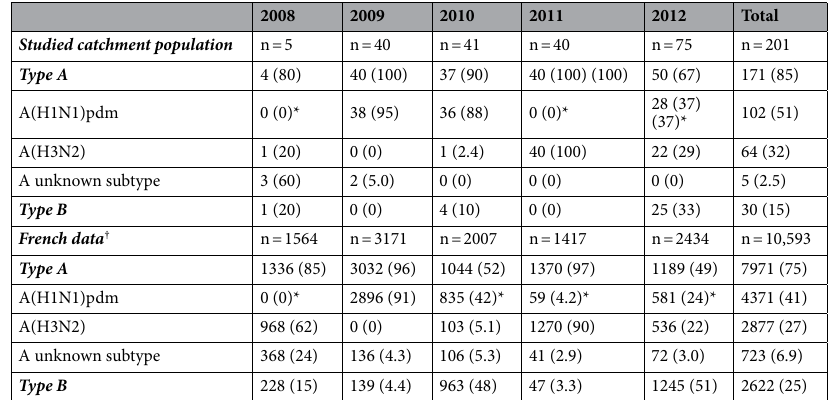
Table 2. Virological data. Data are number (%). * p < 0.05 versus 2009. † From the French countrywide Influenza sentinel network "Groupes Régionnaux d’Observation de la Grippe” (GROG; www. grog. org).